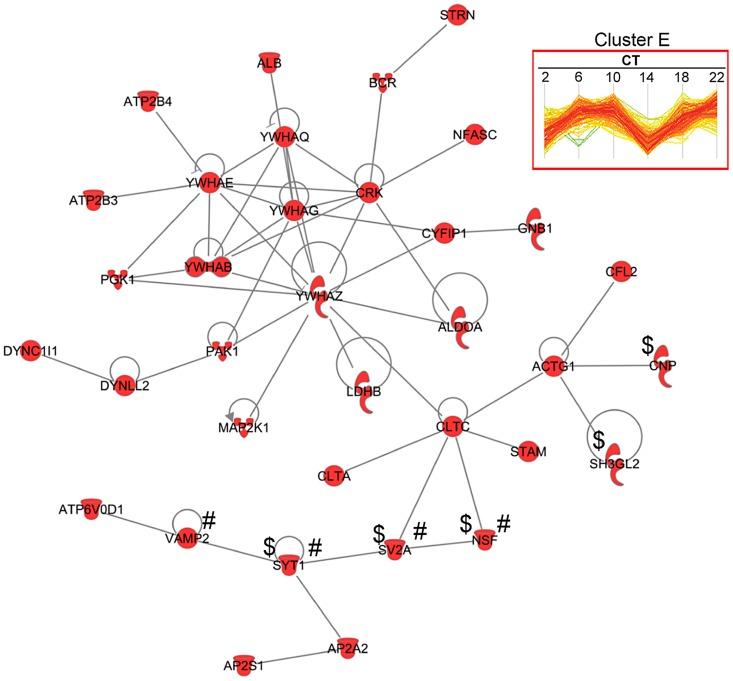
Protein interaction network of cluster E proteins.A total of 35 proteins from cluster E had direct protein-protein interactions based on IPA network analysis. Of note, proteins involved in neurotransmitter release (#) and synaptic transmission ($) were observed in this network.